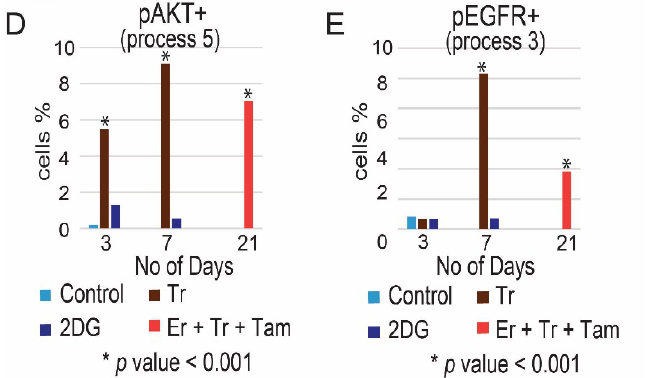
Figure 5. Map of the evolutionary trajectory of MDA-MB-231 cells revealed a switch in signaling state following partial treatment. MDA-MB-231 cells were treated with monotherapies/combination of drugs (Tr, 2DG and Er + Tr + Tam) once a week for 21 days and allowed to regrow. Then, CSSS analysis of single-cell flow cytometry data was performed to map subpopulations that expand in response to different treatments. Cell-specific signaling signature (CSSS) was assigned to each cell which divided the tumor mass into distinct cellular subpopulations. Subpopulations of cells with pAKT+ and pEGFR+ processes comprising more than 1% in any of the experimental conditions are presented and quantified. ( A ) 5 unbalanced processes, as identified by the analysis, with the central proteins (those having most significant G values, representing the extent of the participation of a protein in processes) are shown. Proteins colored black are anti-correlated with those colored grey. ( B ) Cells with the same set of unbalanced processes are grouped into subpopulations as represented by different barcodes. Active processes are labeled by either black or grey color. Each barcode (subpopulation) is then color-coded and presented in ( C ). Proteins labeled in black in ( A ) are induced in black processes ( B ). Proteins labeled in grey in ( A ) are induced in grey processes ( B ). ( C ) The evolution of each subpopulation was then followed over time. The size of the circle represents the percentage of subpopulation of cells. ( D – F ) Percentage of pEGFR+ and pAKT+ cells was quantified for each treatment. Quantification of the subpopulations was performed using at least ~30,000 cells from each condition, which were obtained from at least 3 wells and from at least 2 independent experiments for each time point. p -values for each treatment vs. control are presented. (Abbreviations: